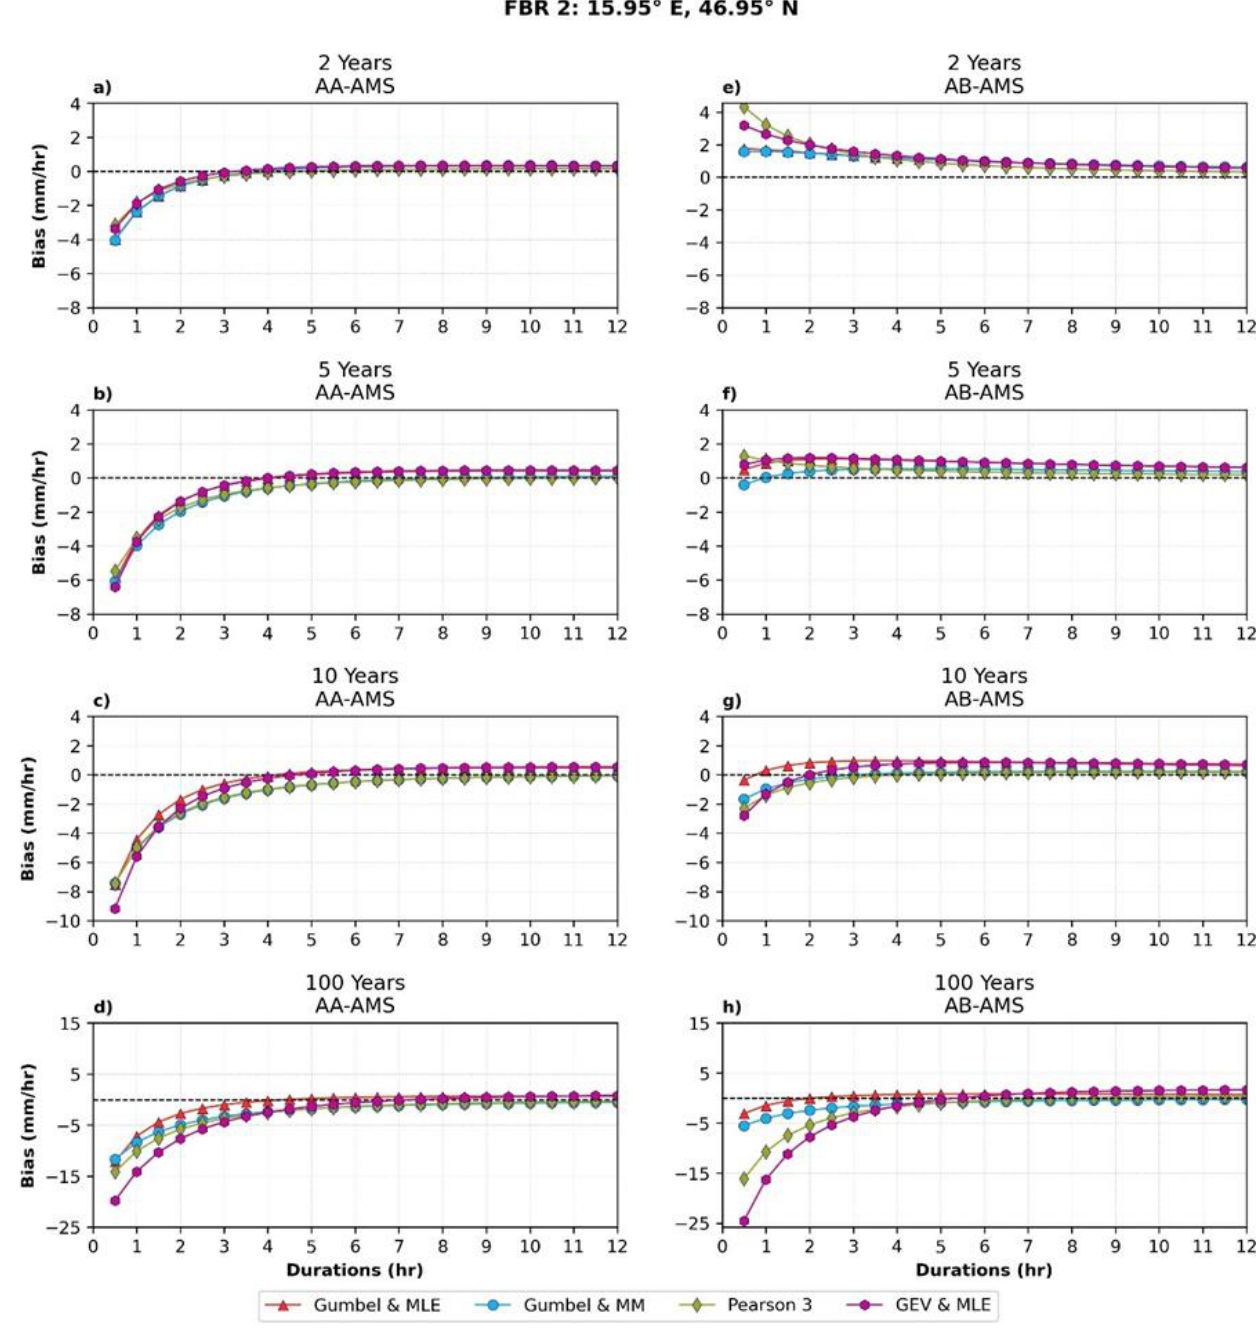
Figure 8. Precipitation intensity biases between IMERG IDFs and the gauge-based IDFs for 2, 5, 10, and 100 year return periods and event durations between 0.5 and 12 h over the FBR 2. IMERG IDF vs. AA-AMS IDF ( left ) and IMERG IDF vs. AB-AMS IDF ( right ).